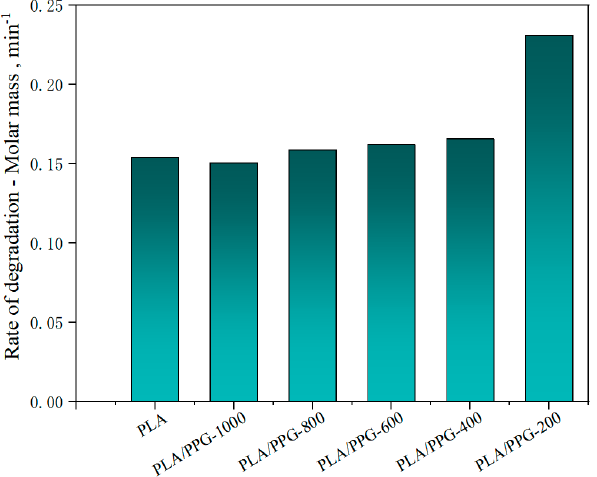
Figure 5. Rate of relative decrease of the temperature-adjusted torque (rate of degradation) in the interval from 15 to 20 minutes for the neat PLA and PLA/PPG composites.